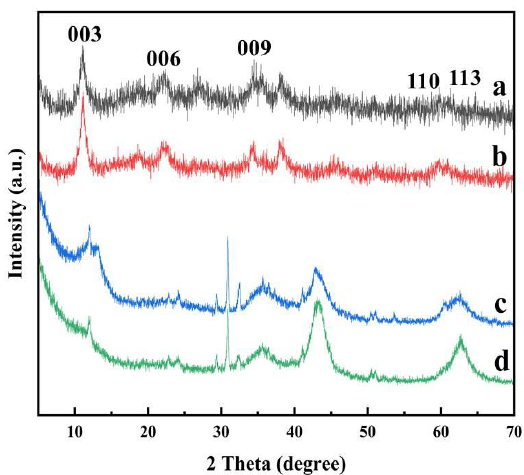
Figure 4. XRD patterns of ( a ) PTB-LDH3, ( b ) PTB-LDH4, ( c ) PTB-LDO3, and ( d )